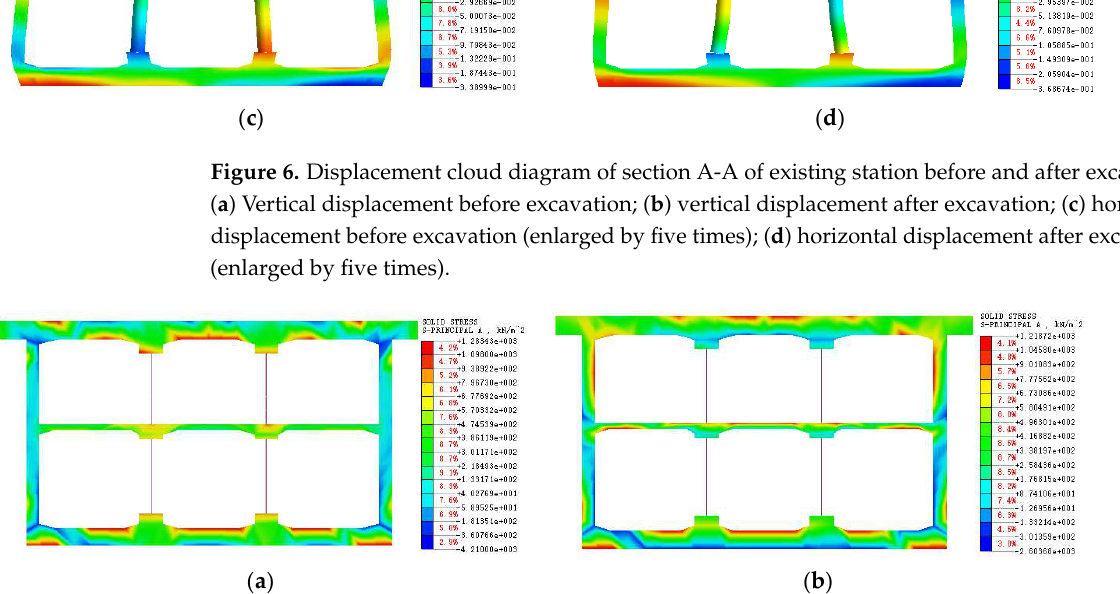
Figure 7. Cloud diagram of section A-A stress of existing station before and after excavation. ( a ) Cloud diagram of stress before excavation; ( b ) cloud diagram of stress after excavation.